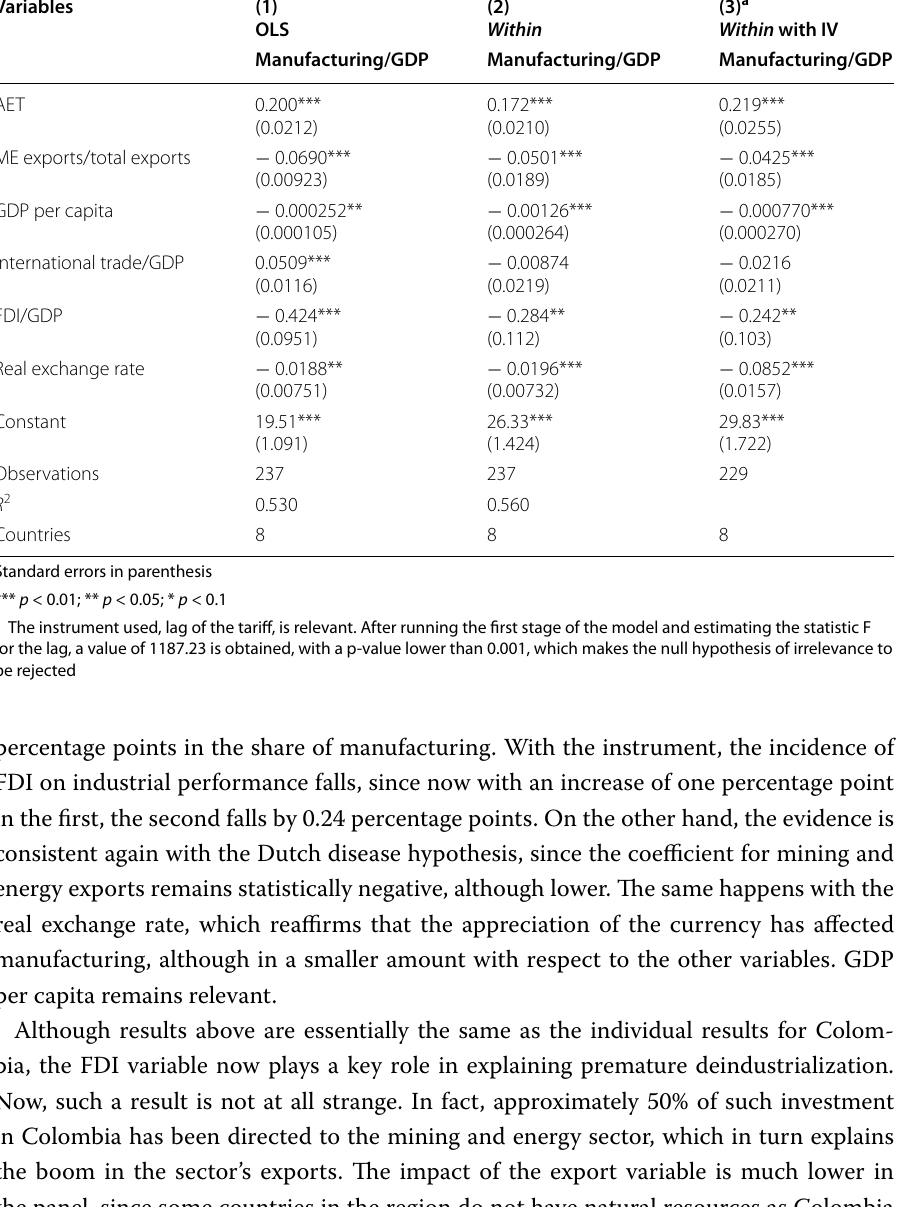
Table 2 Results for the panel